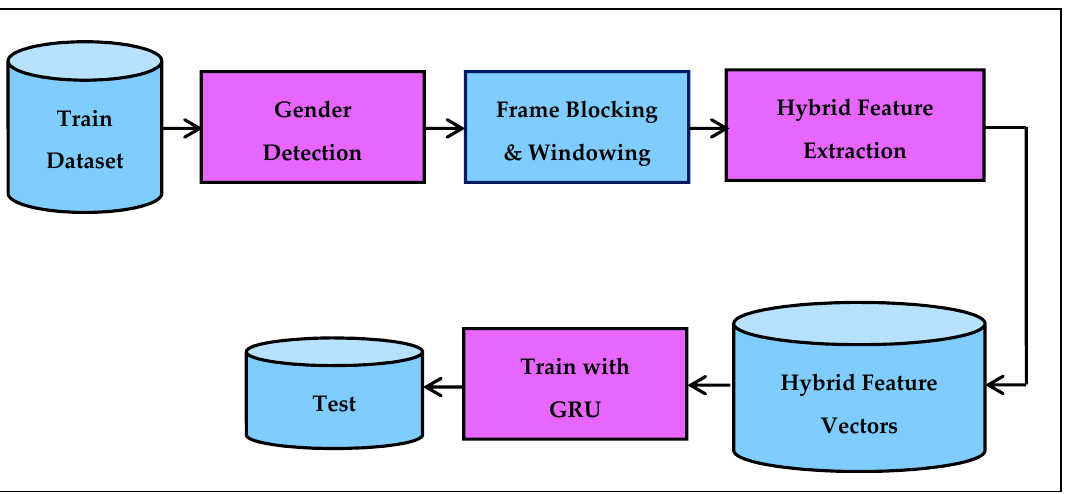
Figure 1. Flow chart of the proposed system. GRU: gated recurrent unit.